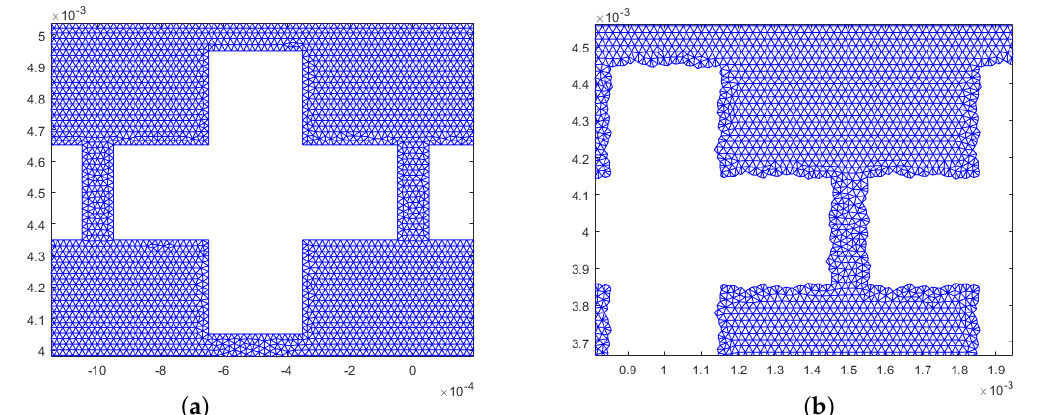
Figure 4. ( a ) Meshed domain in the vicinity of a regular Swiss cross-shaped hole. ( b ) Mesh in the vicinity of rough cross-shaped holes defined by the roughness parameters δ = 5 µ m and λ 0 = 5 µ